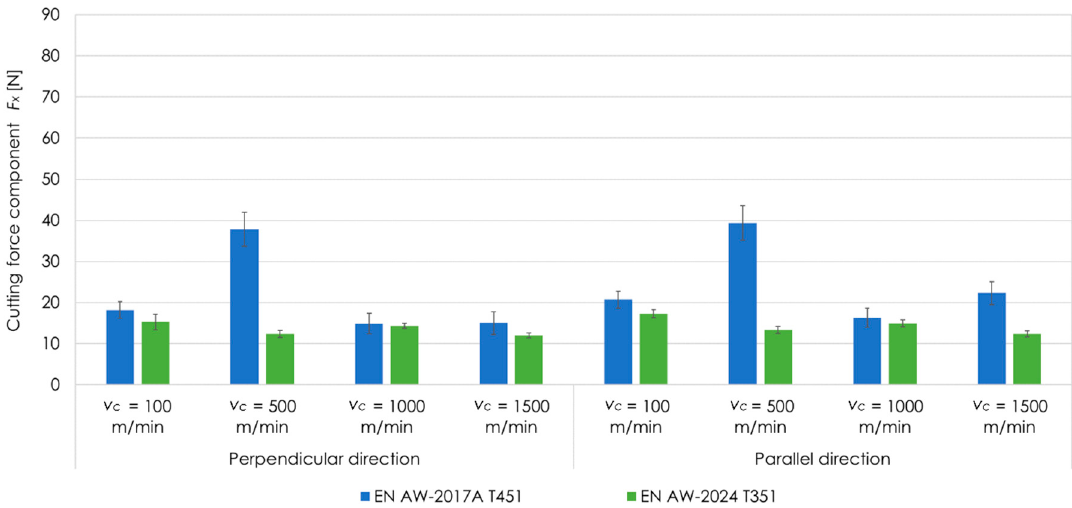
Figure 8. Comparison of cutting force component F x as a function of cutting speed v c for tested aluminium alloys as well as perpendicular and parallel milling direction in relation to the rolling direction at a p = 0.1 mm.